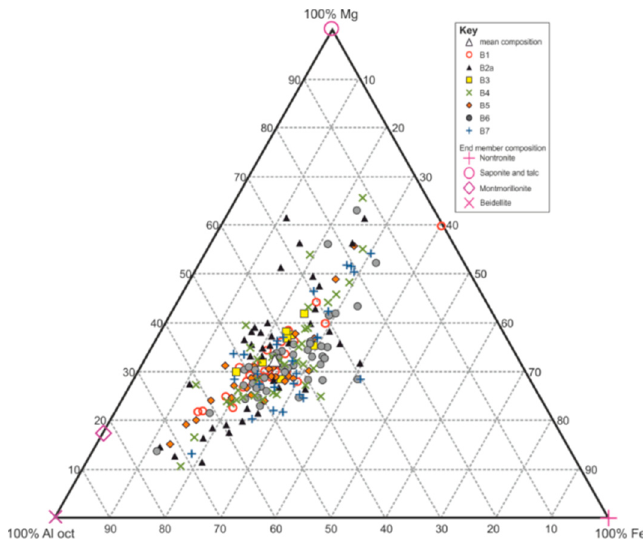
Figure 10. Borehole KM1 triaxial octahedral Al–Fe–Mg cations plot using atoms per functional unit (APFU) values. All clay data colour coded by sample. End member nontronite, beidellite, talc, saponite and montmorillonite points included for reference.